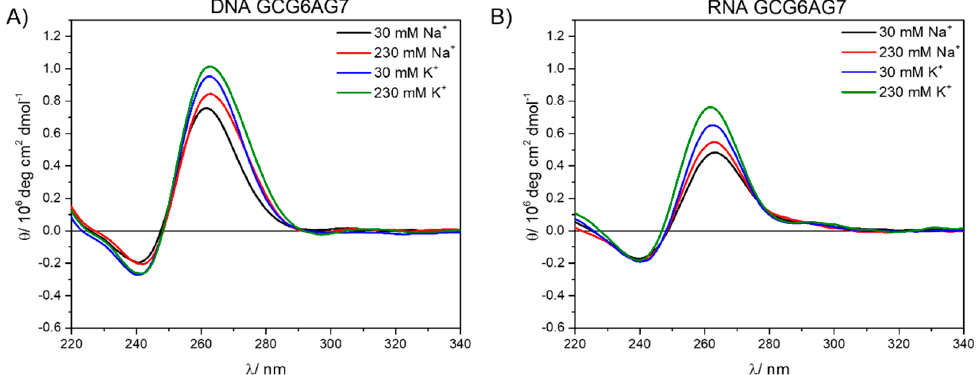
Figure 5. DNA ( A ) and RNA ( B ) circular dichroism spectra at 30 mM and 230 mM of sodium (black and red) and potassium (blue and green).